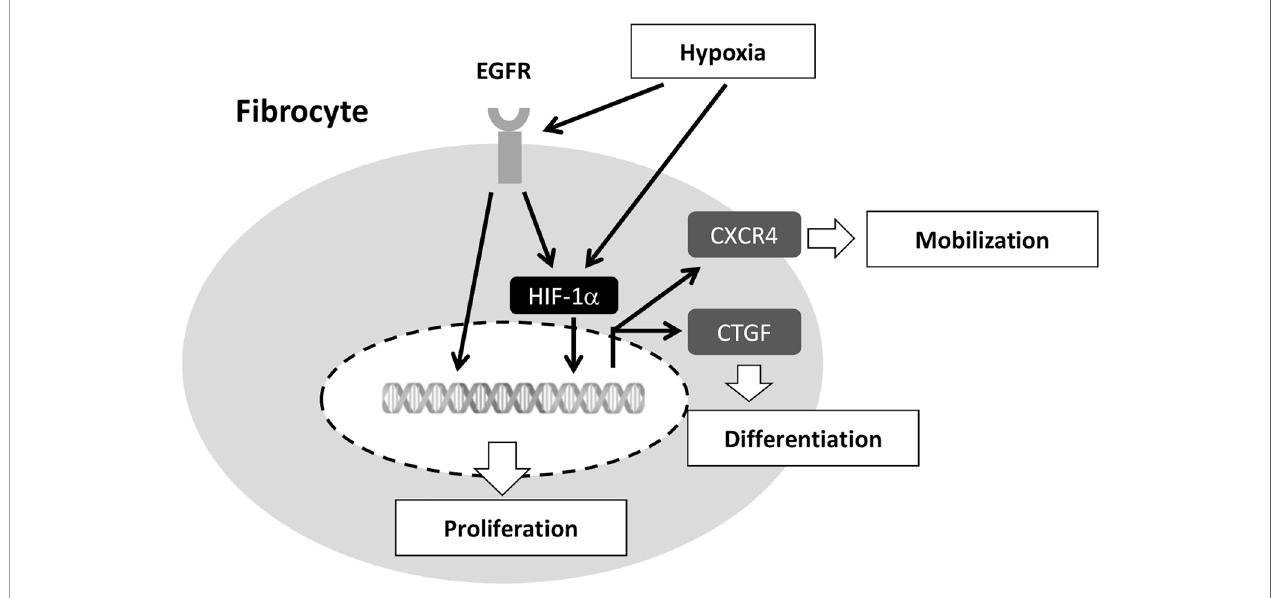
FIGURE 8 | Proposed molecular mechanisms involved in hypoxia-induced fi brocyte mobilization, proliferation, and differentiation. Hypoxia up-regulates EGFR, HIF- 1 a , and CTGF. Hypoxia-induced EGFR transactivation promotes the transcription of HIF-1 a -targeted genes (e.g. CTGF and CXCR4). Elevated HIF-1 a increases CXCR4 and CTGF expression, leading to increased number of fi brocytes recruited into the circulation and differentiated into myo fi broblasts. EGFR, epidermal growth factor receptor; CXCR4, CXC chemokine receptor type 4; CTGF, connective tissue growth factor; HIF-1 a , hypoxia-inducible factor-1 a